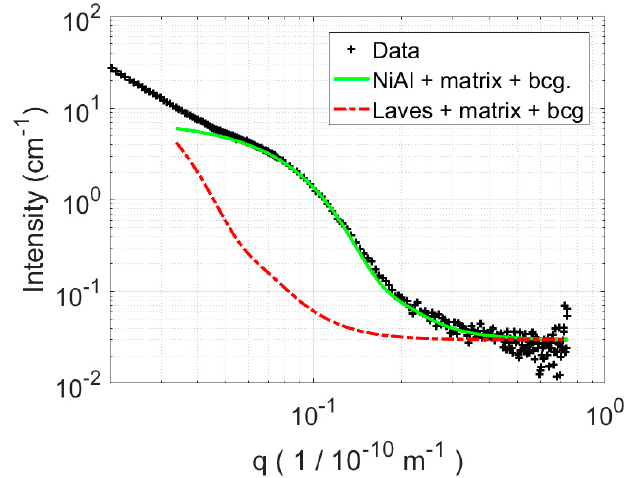
Figure A2. Example fit using SasView for a sample austenitised at 960 °C for 1 h and then aged at 540 °C for 1 h.